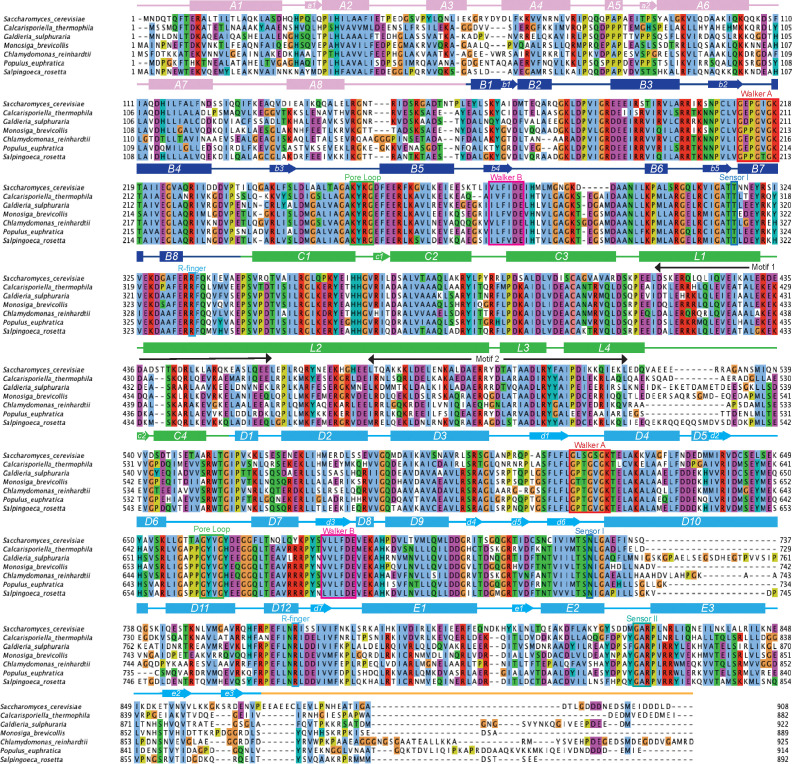
Alignment comparing ScHsp104 to Hsp104 homologs that rescue TDP-43 toxicity.Amino acid sequences of the indicated Hsp104 homologs were aligned using Clustal Omega, and the multiple sequence alignment was visualized with JalView. Positions in the alignment are colored by Clustal X convention: conserved hydrophobic positions (A,I,L,M,F,W,V,C) are blue; conserved basic residues (K,R) are red; acidic residues (E,D) are magenta; polar residues (N,Q,S,T) are green; aromatic residues (H,Y) are cyan; conserved cysteines are pink; glycines are orange, prolines are yellow. Structural elements of Hsp104 are indicated.